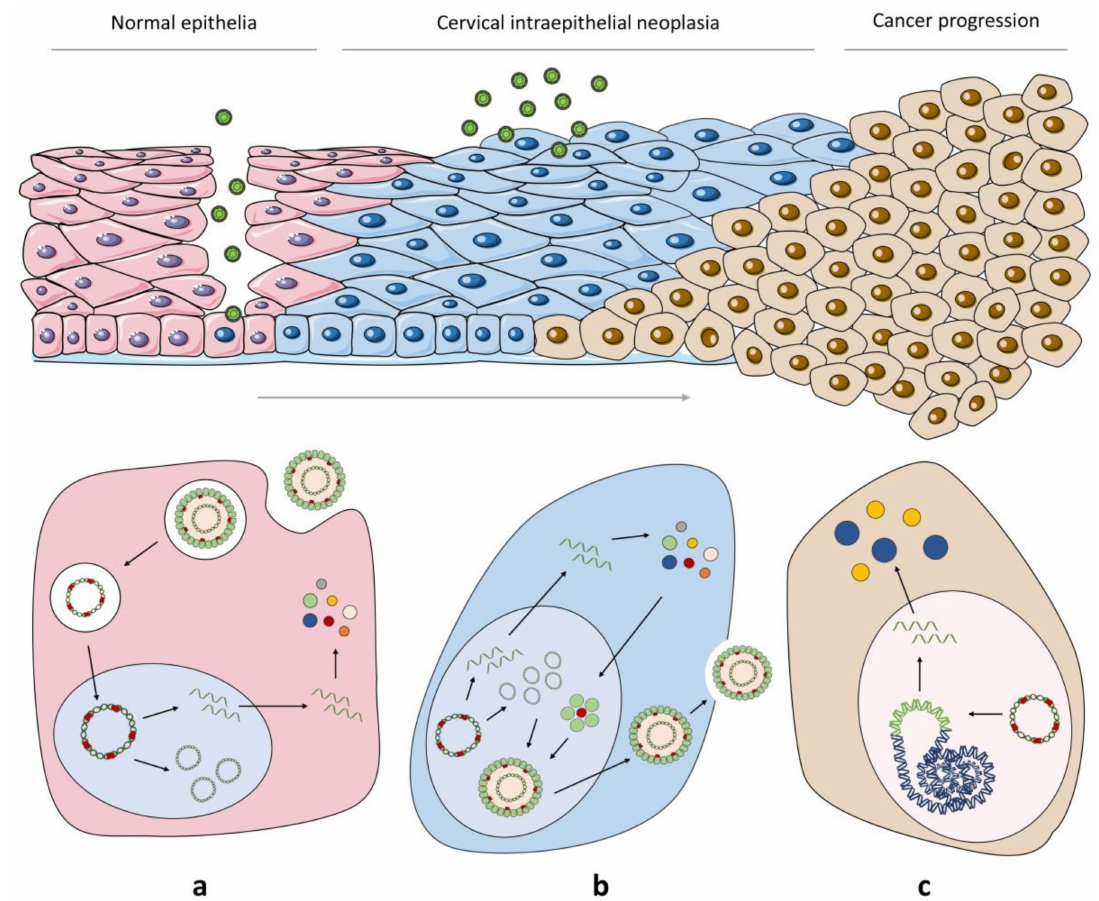
Figure 2. HPV life cycle and progression to cancer. ( a ) HPV reaches the basal cells of the epithelium through tissue abrasions. Upon recognition, endocytosis of the virion occurs, and HPV is transported through the endosomal pathway. At endosomes, L2 mediates viral egressing and HPV vesicles are transported along microtubules to the nucleus, where early transcription is initiated, with a quick but transient expression of the early proteins and through the recruitment of the cellular DNA replication machinery. Afterwards HPV can enter the latency phase. ( b ) Once basal cells start to di ff erentiate, they migrate towards the surface of the tissue. Here, structural proteins are expressed, allowing virion assembly and release, which occurs alongside with tissue desquamation. ( c ) Viral persistence in basal cells can result in HPV genome integration, which promotes cancer